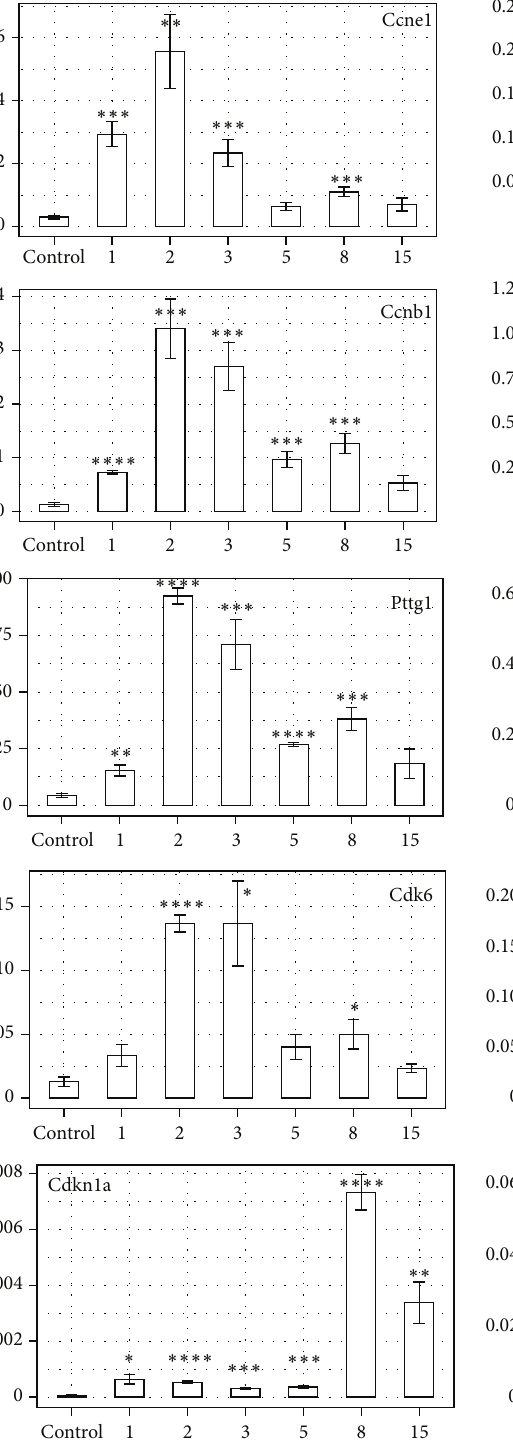
Figure 5: QPCR assay of Ccne1, Ccnd1, Ccnb1, Nek6, Pttg1, Cdk4, Cdk6, Cdk1, Cdkn1a, and Cdkn1c mRNA expression in the regenerating rat adrenal cortex compared to control adrenals. Bars represent mean ± SEM ( 𝑛 = 3 ). All samples were amplified in triplicate, and HPRT gene expression was used as reference to normalize data. Statistically significant differences in relation to control group: ∗ 𝑃 < 0.05 ; ∗∗ 𝑃 < 0.02 ; ∗∗∗ 𝑃 < 0.01 ; ∗∗∗∗ 𝑃 < 0.001